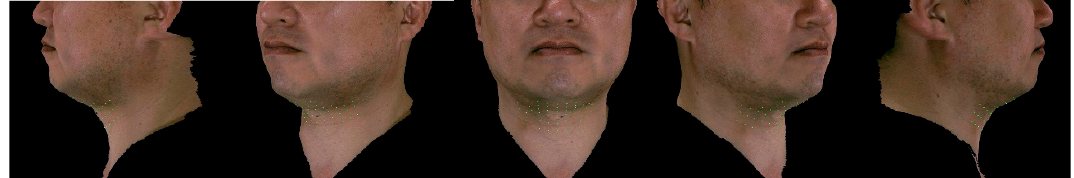
Figure 2. Sample of a set of three-dimensional clinical photos of a male patient.